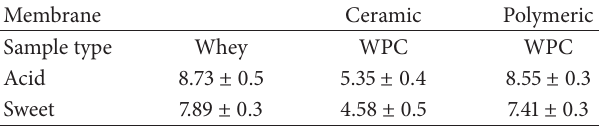
Table 1: Protein concentration (g/L) in crude whey and WPC products by UF processes.